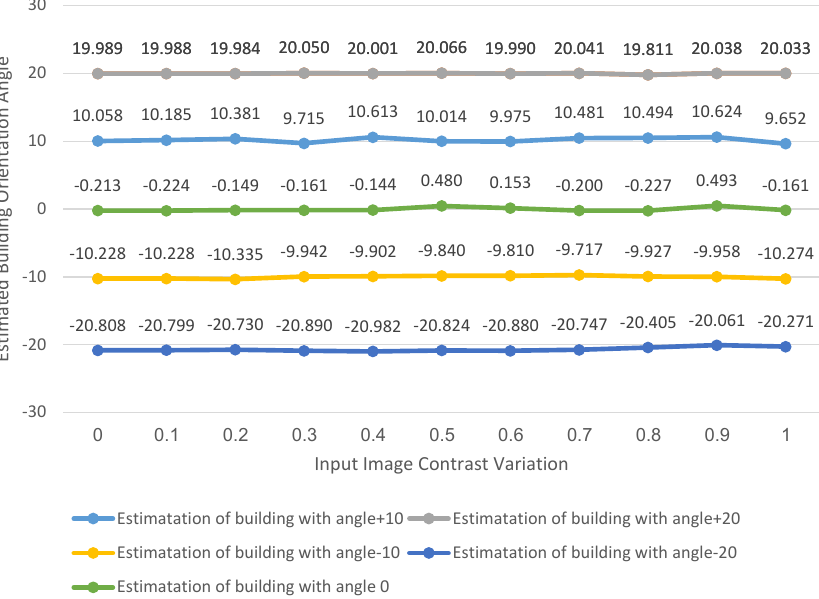
Figure 13. The effect of building image contrast variation on the building orientation estimation results for our proposed approach.